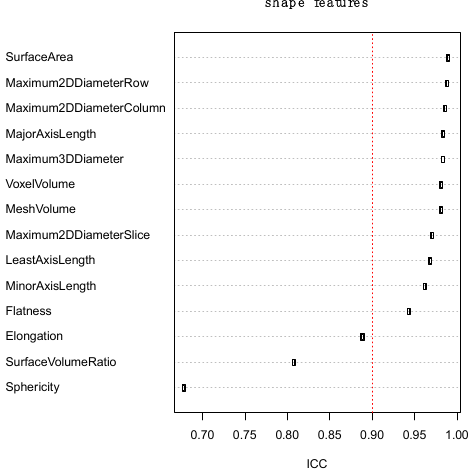
Figure 2. Robustness of shape features across segmentations. The vertical dashed red line indicates the ICC > 0.9 threshold. Pyradiomics provides 14 shape features. The robustness is above 0.60 for all of them. However, three of them are less robust (<0.90) across segmentations (Sphericity, SurfaceVolumeRatio and Elongation); this might be because they largely depend on the precise ROI contours. They do not depend on bin-width, distance, resolution or interpolator. With the exception of Flatness, the other features have a robustness greater than